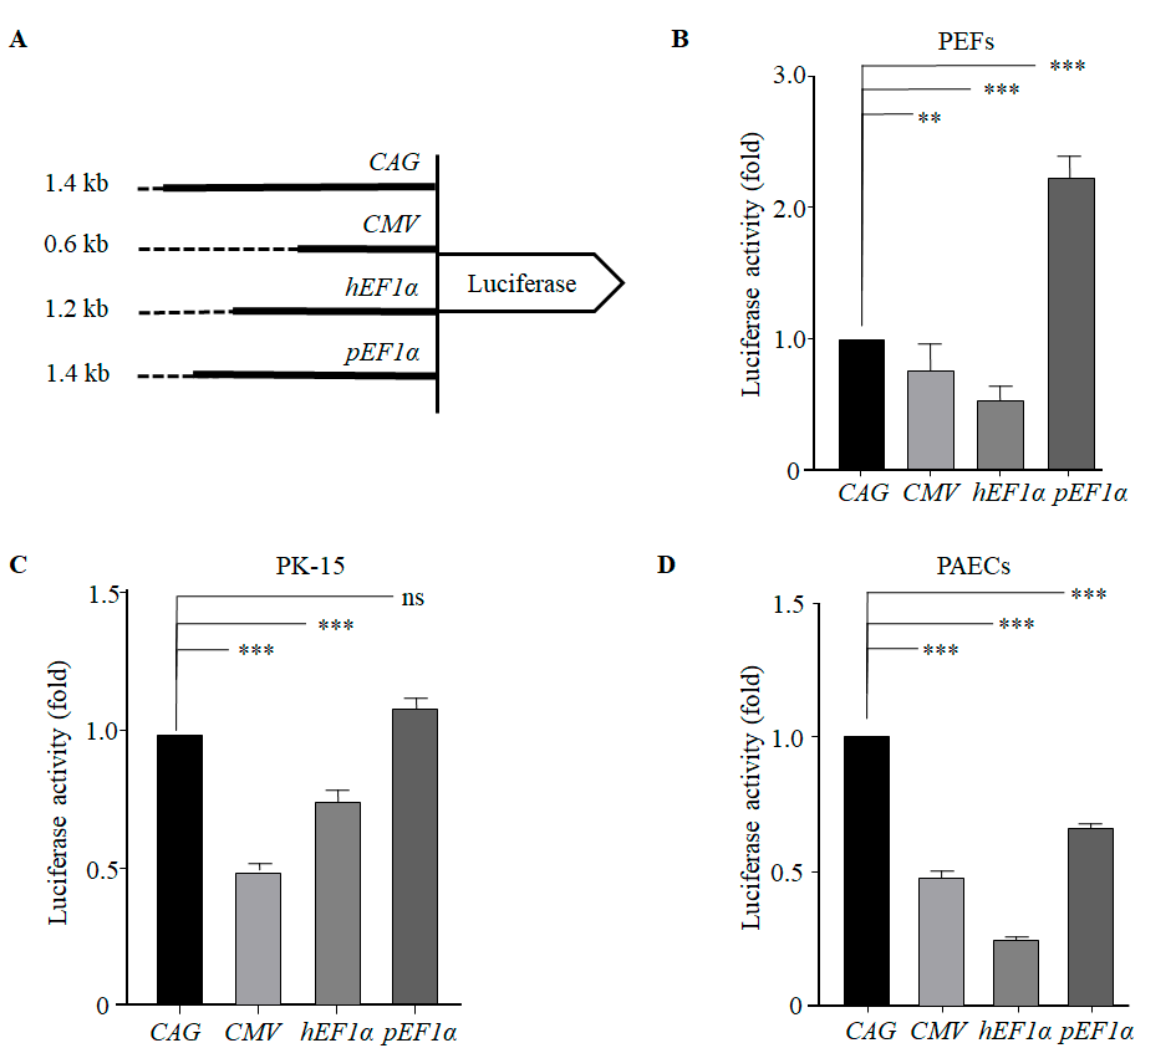
Figure 2. Relative activity of various promoters in regulating luciferase expression in different types of porcine cells. ( A ) Schematic diagram of the luciferase reporter constructs used in the study. Numbers on the left indicate the approximate length of the respective promoters. ( B ) Promoter activity in PEFs. ( C ) Promoter activity in PK-15 cells. ( D ) Promoter activity in PAECs. All values are normalized relative to values for the CAG promoter. CAG, cytomegalovirus enhancer/chicken β -actin promoter; CMV, cytomegalovirus promoter; hEF1 α , human elongation factor 1 α ; pEF1 α , porcine elongation factor 1 α ; PEFs, porcine ear skin fibroblasts; PAECs, porcine aortic endothelial cells. Values are means ± SEM calculated from three replicates; ns, no significant difference; **, p < 0.01; ***, p < 0.001.